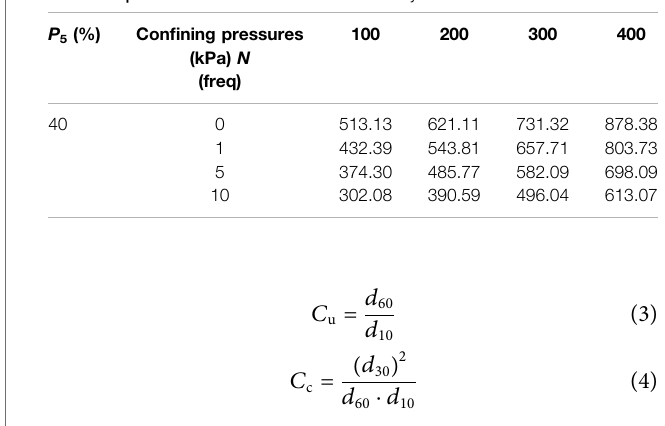
TABLE 1 | Maximum deviator stress obtained by conventional triaxial